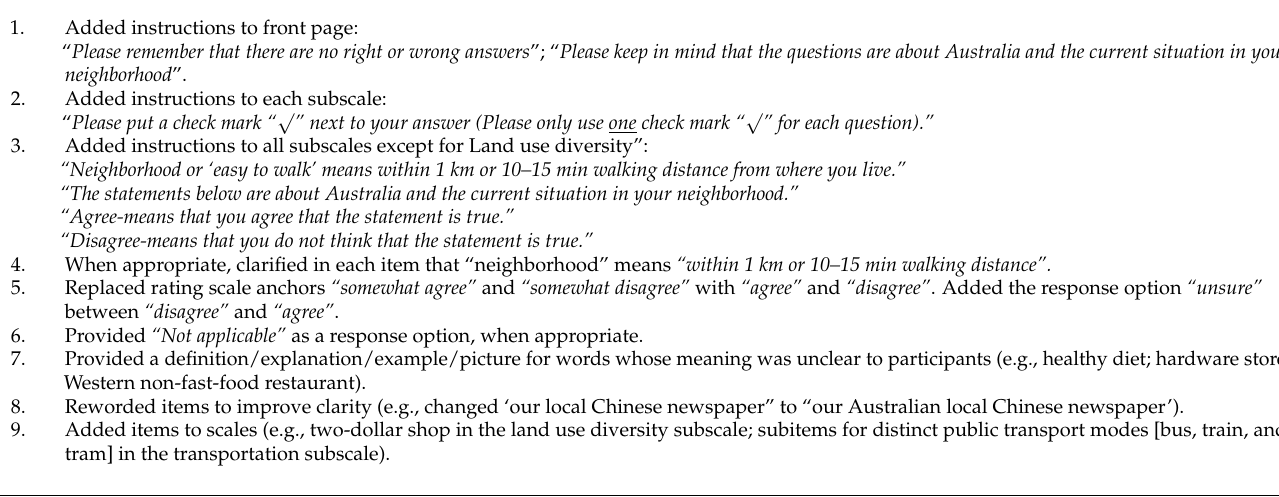
Table 4. Summary of modifications to questionnaires of perceived neighborhood attributes associated with, and perceived barriers to engagement in, physical activity, healthy eating, and socializing for older Chinese immigrants to Australia based on findings from cognitive